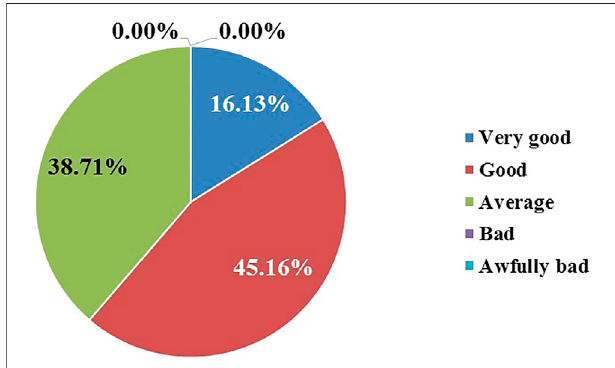
FIGURE 3 | School buildings